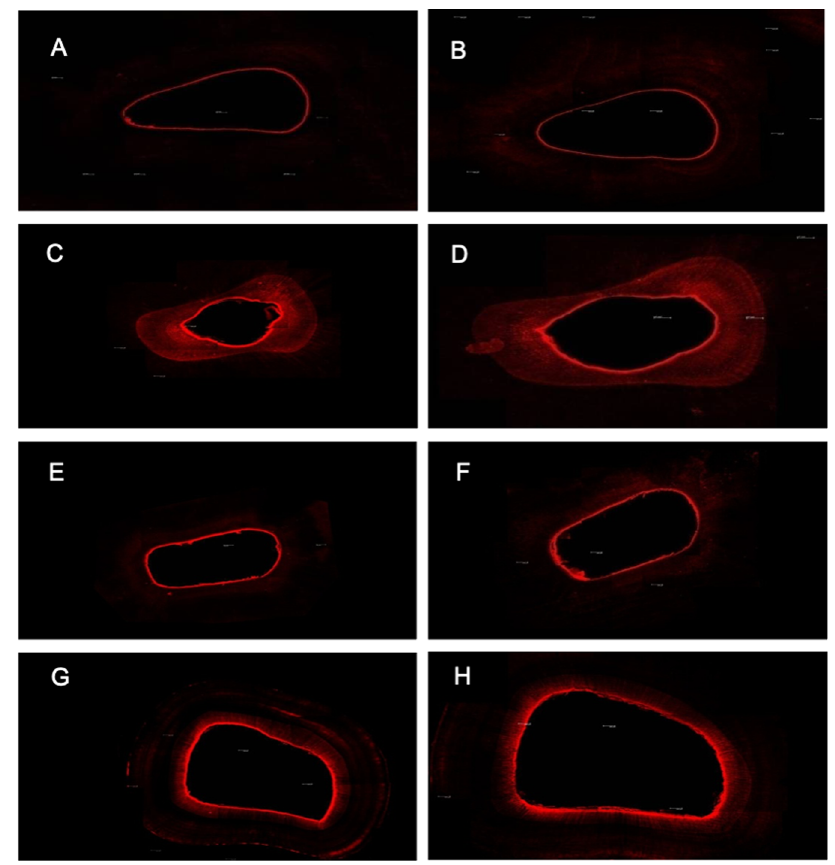
Fig. 3 Images of the penetration of the calcium hydroxide pastes stained with 0.1% B Rodamine at the transversal cuts of 3 (left column) and 5 (right column) millimeters from the apical end of the specimen. A and B Calcium hydroxide with vehicle propylene glycol, ( C and D ) Calcium hydroxide with vehicle propylene glycol associated with the ultrasonic agitation, ( E and F ) Calcium hydroxide with vehicle distilled water, ( G and H ) Calcium hydroxide with vehicle distilled water associated with the ultrasonic